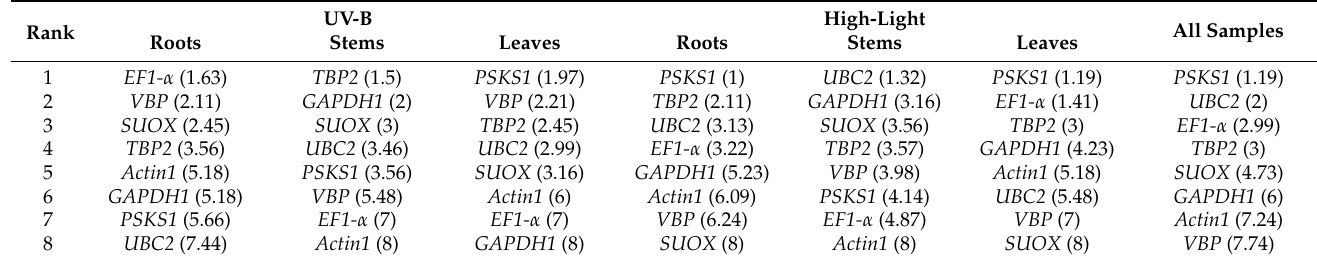
Table 4. Comprehensive stability rankings of eight candidate reference